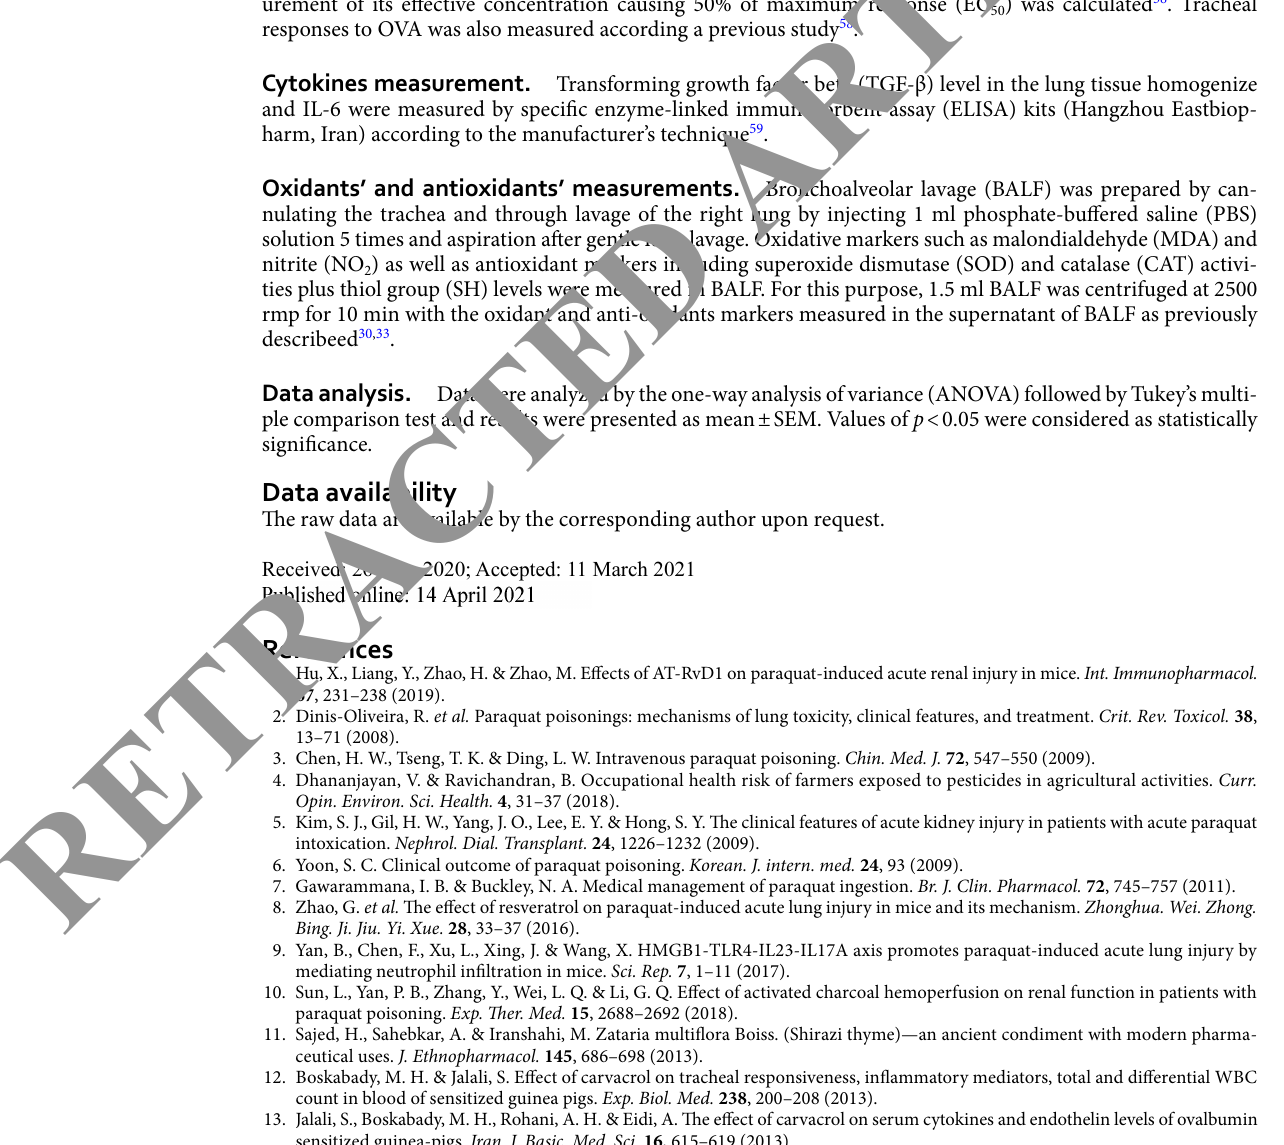
Figure 10. Exposing animals to aerosols of inhaled PQ (54 mg/m 3 ) 8 times (days 1, 3, 5, 7, 9, 11, 13, 15 and treatment of animals with the carvacrol, pioglitazone and dexamethasone for 16 days after the end of exposure period. Animal were sacrificed in day 32 and various variables were